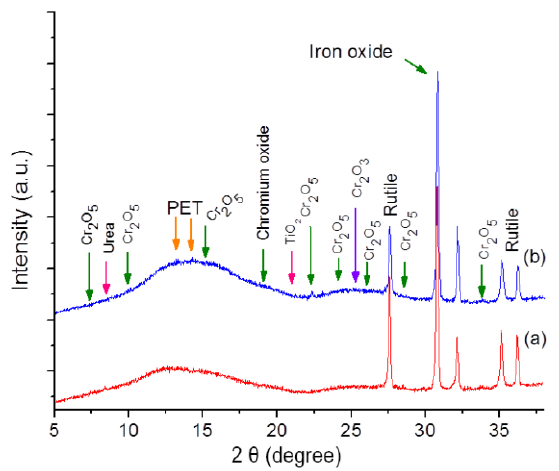
Figure 2. Diffraction pattern between 5 and 35° (2 θ ) of the multilayer materials that form part of the container’s structure. ( a ) Spectral pattern of PET and ( b ) components of the multilayer material.